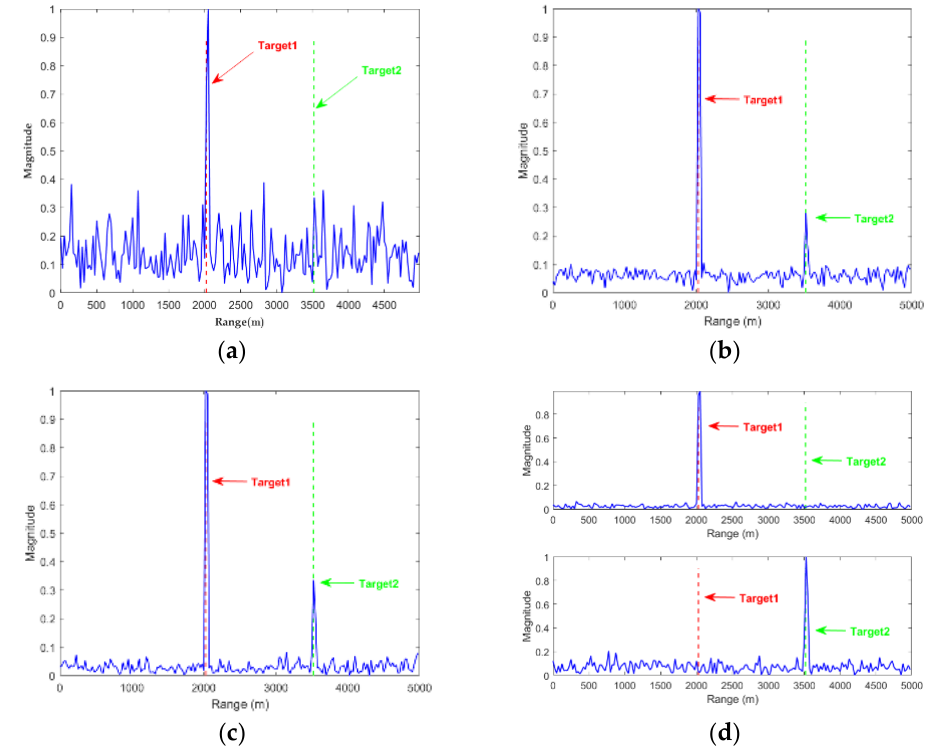
Figure 7. The results of incoherent accumulation, coherent accumulation and PPSA. ( a ) Echo data, ( b ) the result of incoherent accumulation, ( c ) the result of coherent accumulation, ( d ) the result of PPSA.